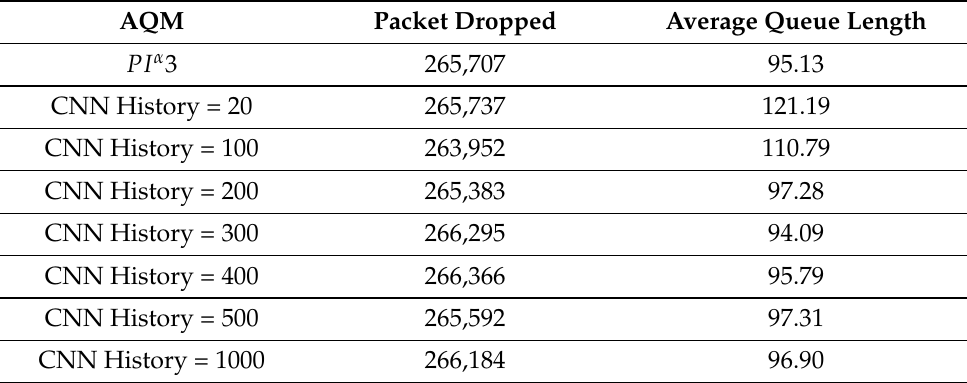
Table 13. Detailed results of queue occupancy obtained for CNN model with the last layer activation function Sigmoid, trained using data regarding PI α 3 controller and parameters: K P = 0.0001, K I = 0.0004, α = − 0.6 and H = 0.9.